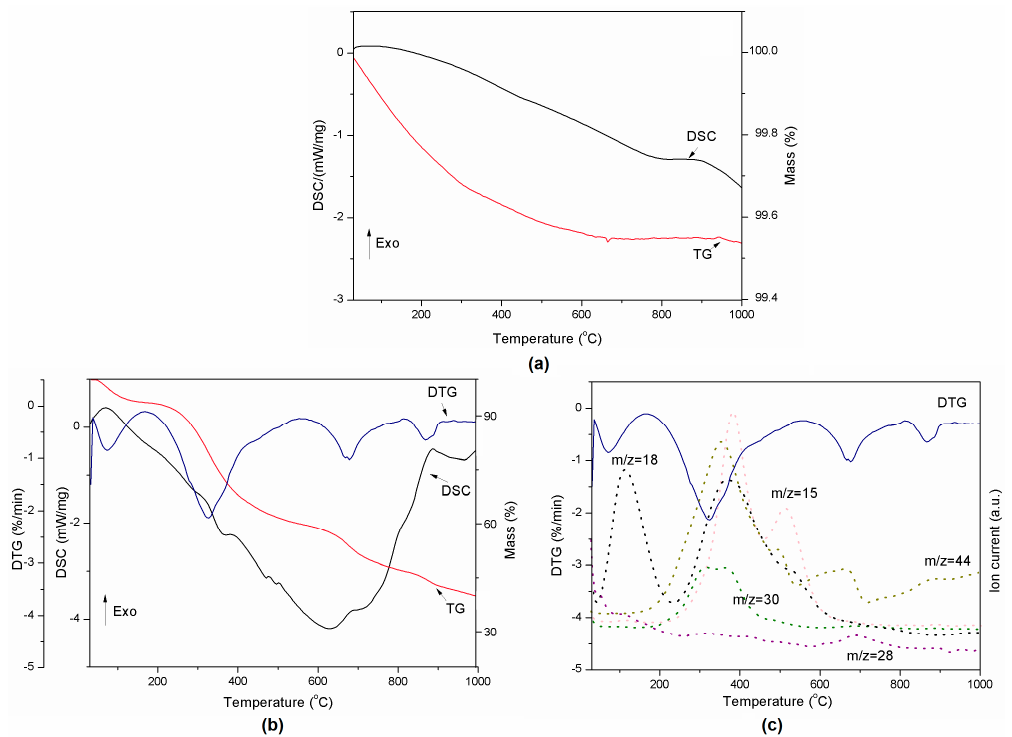
Figure 3. Thermal decomposition of Al 2 O 3 represented by DSC-TG curves ( a ) and thermal decomposition of lignin represented by DSC-TG-DTG ( b ) and DTG-MS curves ( c ).